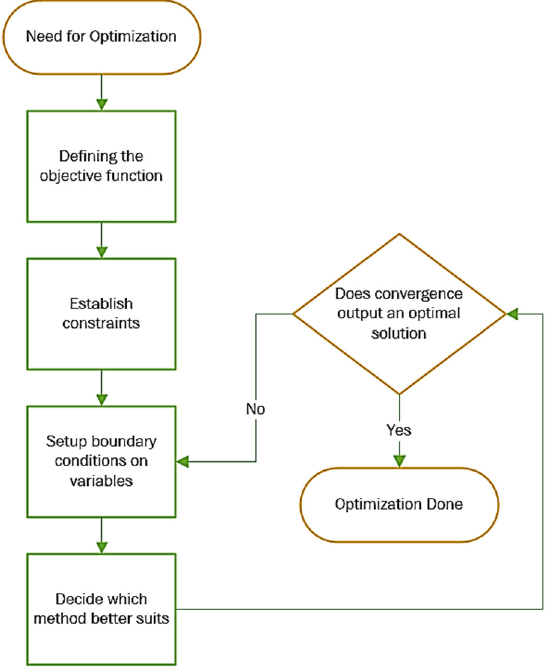
Figure 9. Flow chart of an optimization model.